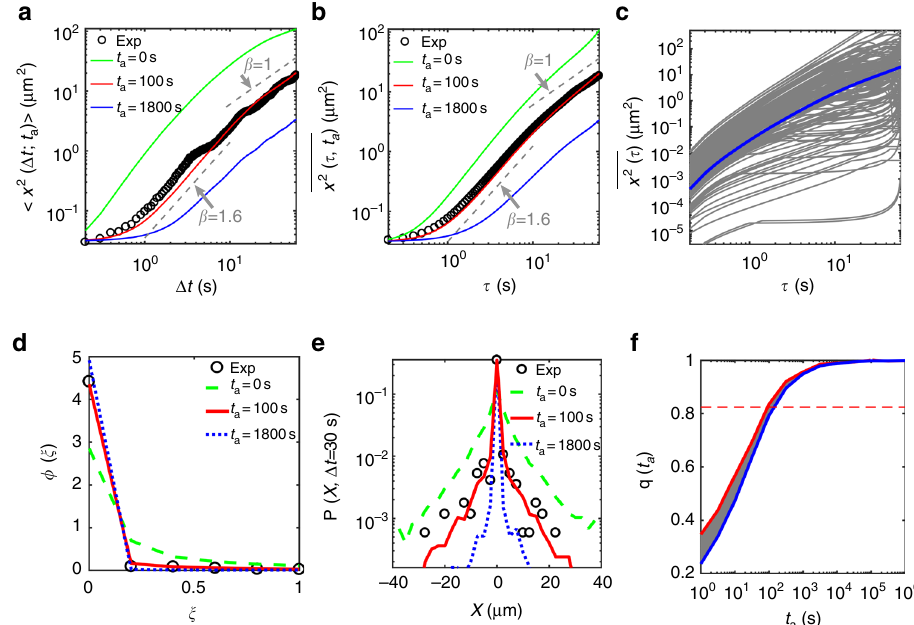
Fig. 4 Quantitative comparison of the experiment and simulation of the aging Lévy walk process. a Comparison of EA MSD curves for the aging Lévy walks at various aging times t a = 0, 100, and 1800 s (green, red, and blue curves, respectively) with the EA MSD from the experiment (black circles, which is the same data shown as red circles in Fig. 2e). The simulation data at t a = 100 s is in excellent agreement with the experimental data. b Comparison of TA MSD curves. The simulation data with aging time t a = 100 s, unequivocally, match both the EA and TA MSDs from the experiment. c Individual TA MSD curves of the aging Lévy walk processes with the aging time t a = 100 s. The thick blue curve is the average of the TA MSDs (gray curves). d Normalized amplitude scatter distributions ϕ ( ξ ) for the TA MSDs as a function of the rescaled variable ξ ¼ x 2 = h x 2 i . The experimental distribution from Fig. 2d (black circles) is compared with the theoretically expected distributions from the aging Lévy walk at three different aging times. e Aged probability density functions P ( x , Δ t ) of mRNP particles from the experiment and the aging Lévy walk simulations. f A fraction q ( t a ; T ) of the trajectories showing no run at all in [ t a , t a + T ] as a function of t a . Two theoretical curves for the aging Lévy walk were obtained from simulations with and without the uncertainty of ~1 μ m (red and blue curves, respectively) for identifying the silent trajectories. Thus, the shaded region indicates the expected probabilities q ( t a ; T ) in theory. The horizontal dashed line represents the experimental values for mRNP particles. It can be seen in the plot that the expected aging time is about t a = 100